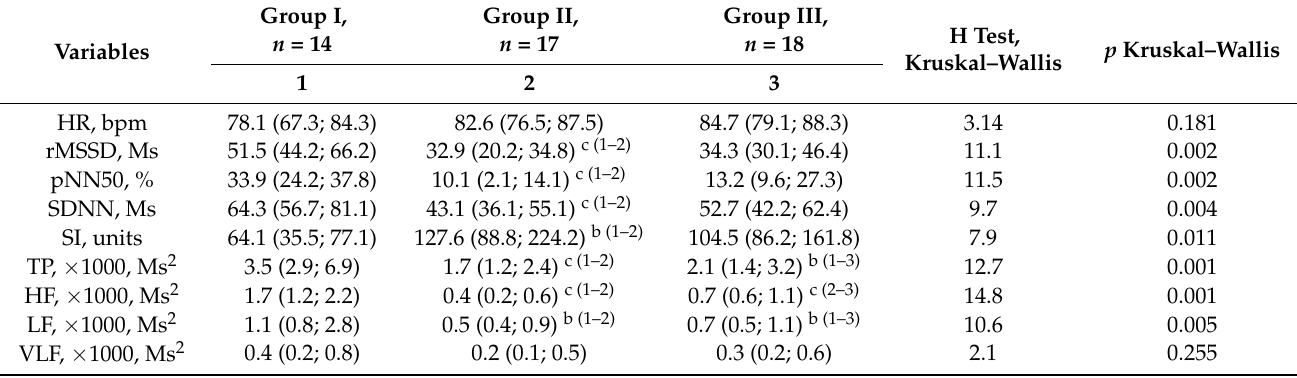
Table 2. Heart rate variability parameters in 16–17-year-old adolescents with different risks of IA a